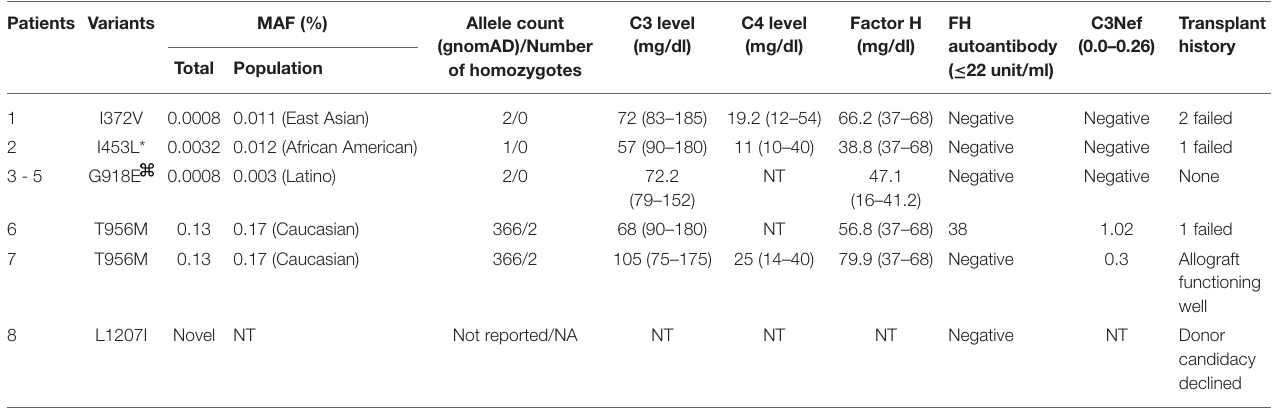
TABLE 1 | Genetic, immunologic, and clinical data from the TMA/C3G cohort at Washington University School of Medicine (WUSM). Patients Variants MAF (%)